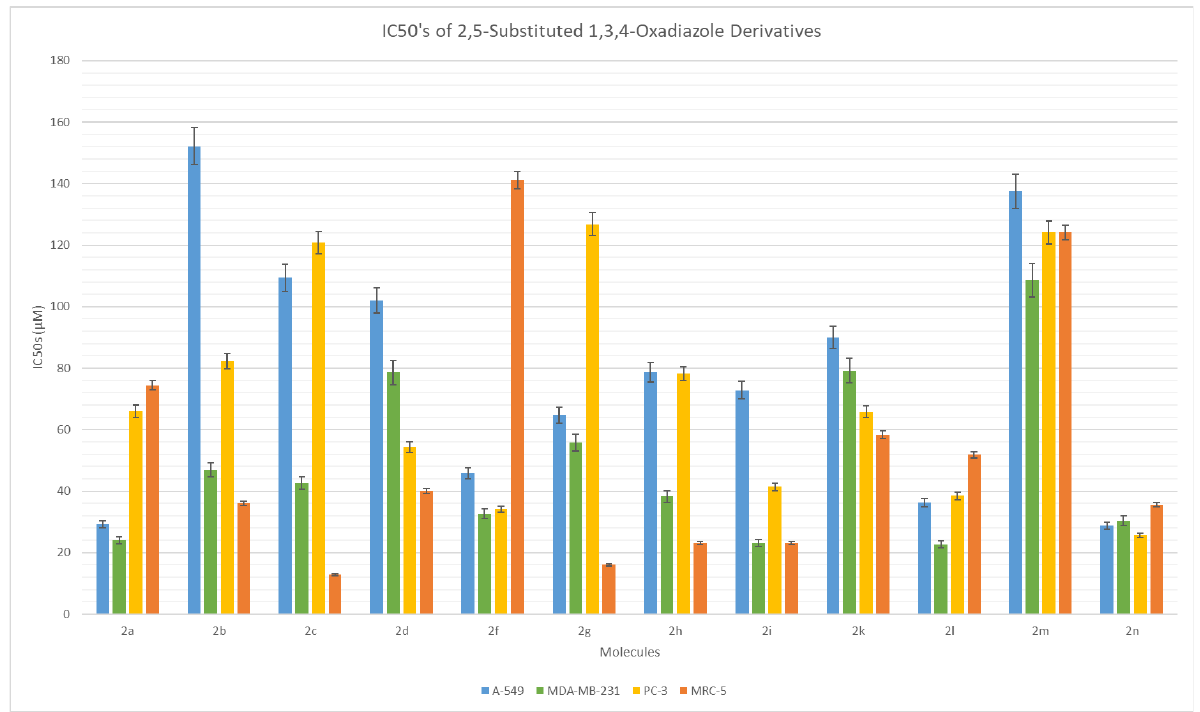
Figure 3. IC50 values of 2,5 substituted 1,3,4-oxadiazoles on A549, MDA-MB-231, and PC3 cell lines and MRC5 healthy human cells. Cells were treated with increasing dosages of (25 – 300 M) com- pounds. Control cells were treated with an equal amount of DMSO. Error bars show